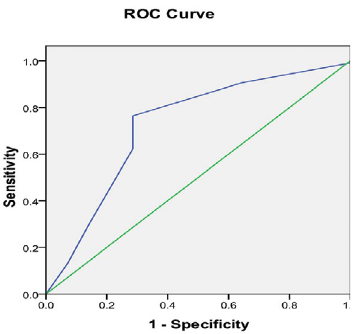
Figure 4: Correlation between Modified Alvarado score and RIPASA score Analysis of correlation between Modified Alvarado score and RIPASA score showed a correlation between Modified Alvarado score and RIPASA score (correlation coefficient 0.790) with p-value <0.001.(fig. 4) Table 6: Comparison between RIPASA and